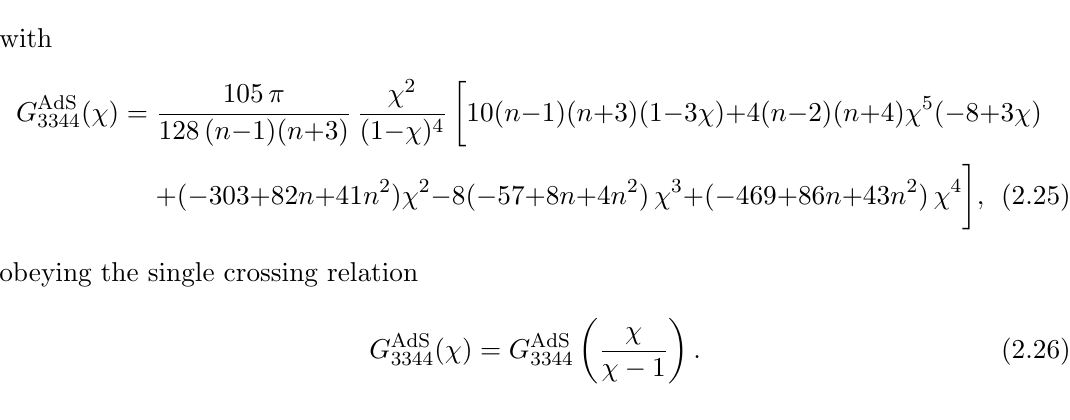
Figure 3 . Tree diagrams contributing the mixed boundary correlator ⟪ ϕ 3 ϕ 3 ϕ 4 ϕ 4 ⟫